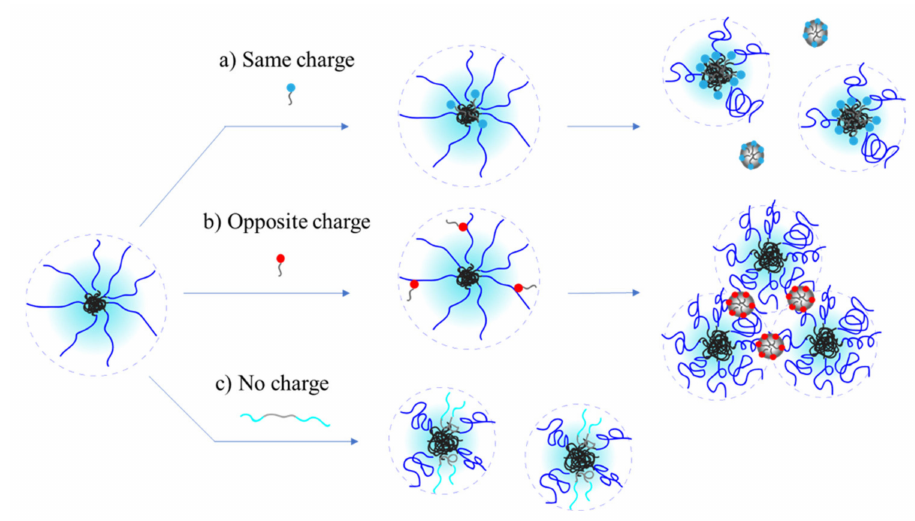
Figure 5. Proposed schematic model for APBE/surfactant